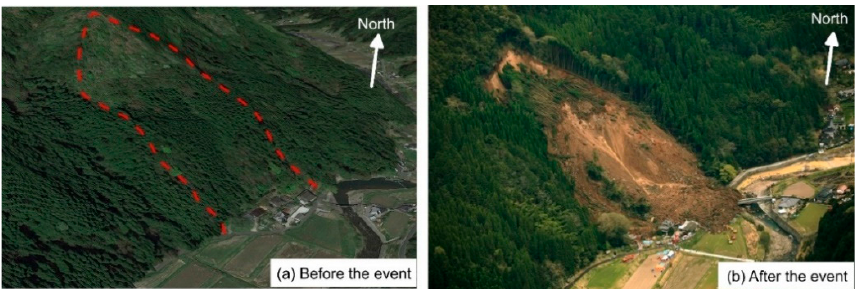
Figure 2. Overview of the 11 April landslide event in Nakatsushi city, Oita, 2018. ( a ) Before the event. Photo taken at 15 April 2016, from Google Earth. ( b ) After the event. Photo provided by Japan Asia Group.